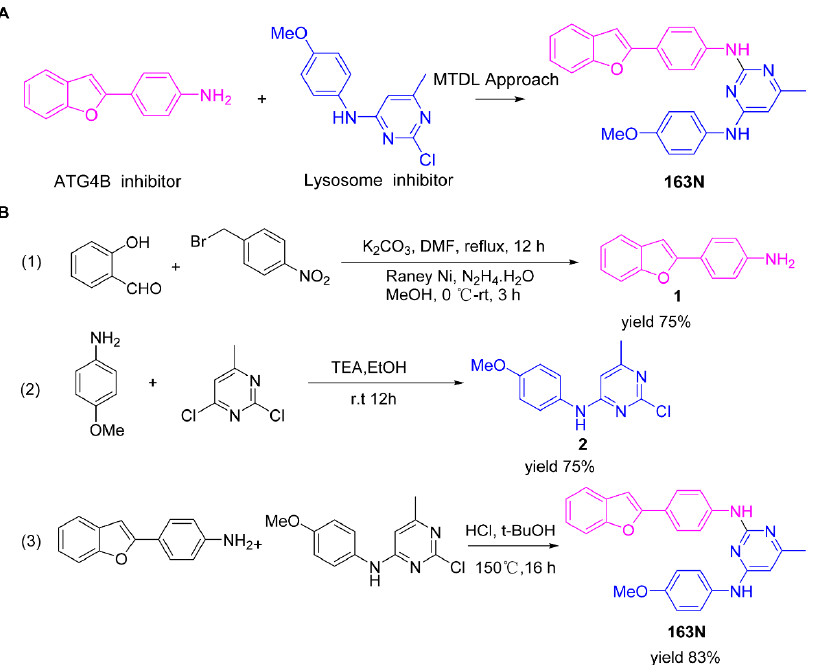
Figure 1. Graphical synthetic route of 163N. ( A ) The structure of 163N carries both 2-phenylbenzofuran and 6-methylpyrimidine-2,4-diamine. ( B ) Synthesis of 163N. Table 1. List of the screened ATG4B inhibitors.